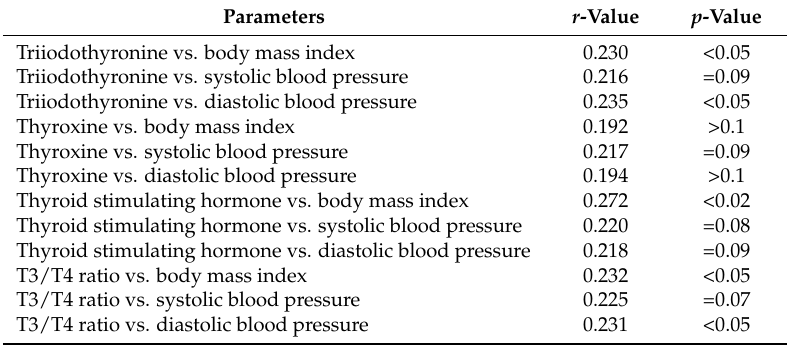
Table 2. Correlation of measured thyroid hormones and blood pressure with body mass index in obese